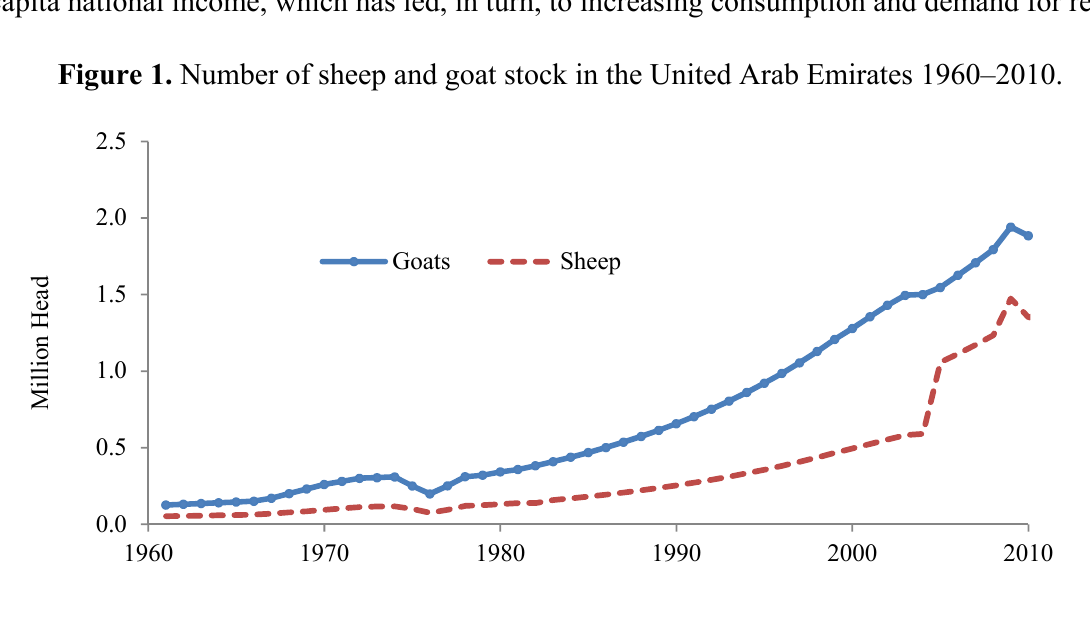
Source: Food and Agriculture Organization (FAO), 2013